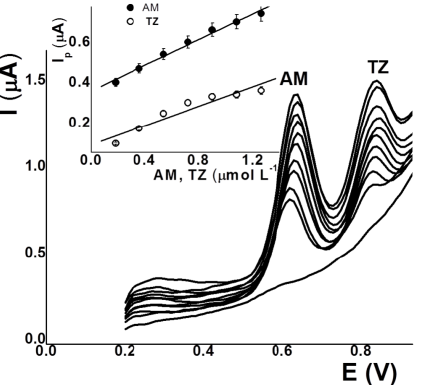
Figure 4. AdSV and calibration curves for increasing concentrations of AM and TZ with SPCE.